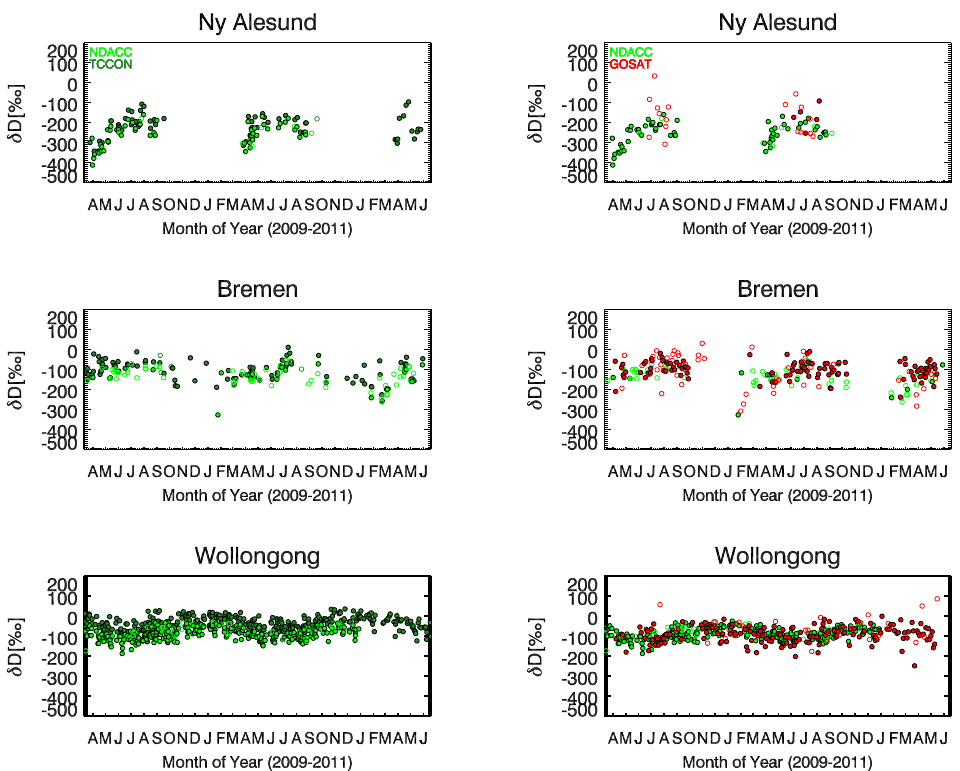
Fig. 16. Comparison between δ D retrieved from TCCON (left panel) or GOSAT (right panel) and NDACC at the three sites Ny- ˚Alesund, Bremen and Wollongong. All data are given as daily averages (open symbol indicates that only a single data point is used). The GOSAT retrievals are the quality-filtered retrievals.